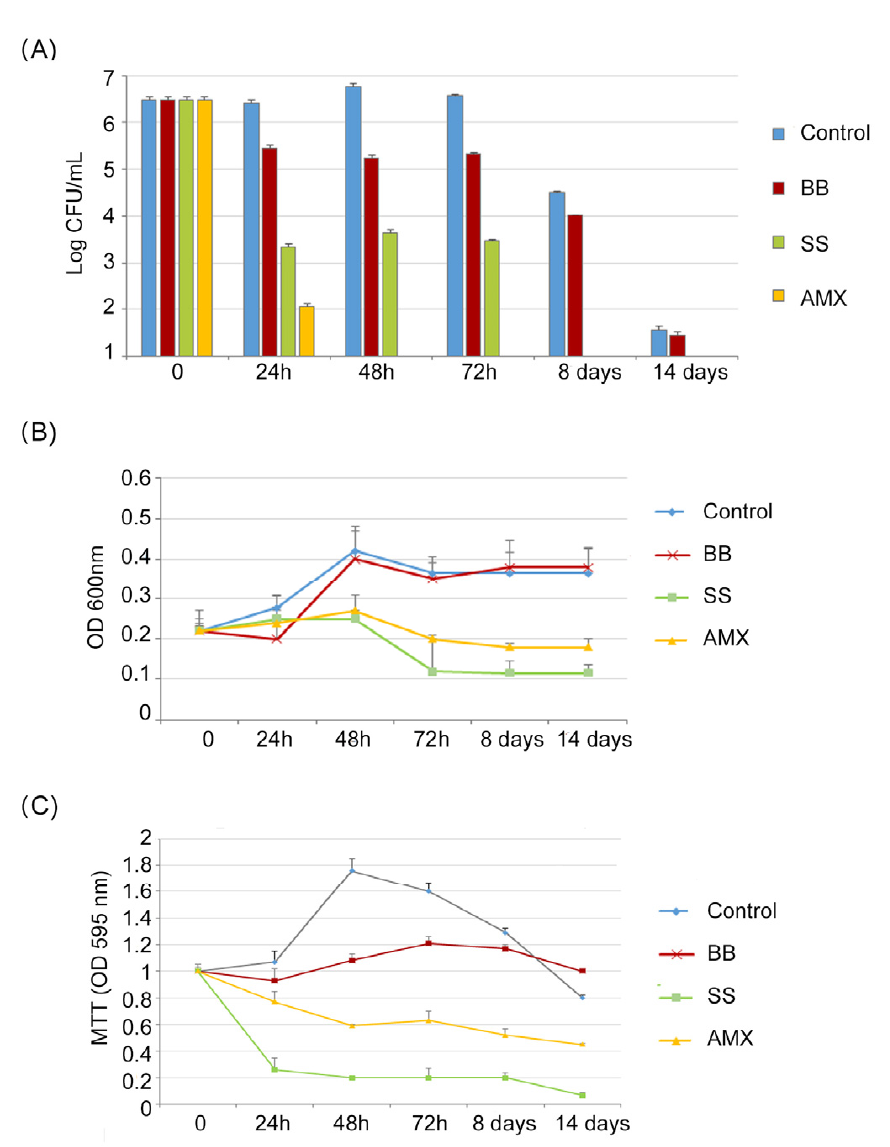
Figure 2. Induction of dormancy . ( A ) Culturable cell numbers of H. pylori incubated in a microaero- bic atmosphere at 37 ◦ C under different conditions. Control (BB + 2% FCS); BB (Brucella broth) and SS (saline solution) for the VBNC protocol; AMX (amoxicilllin 10xMIC) for the AP protocol recorded at t = 0, 24 h, 48 h, 72 h, 8 days, and 14 days. ( B ) Total number (OD 600 ) of H. pylori incubated in a microaerobic atmosphere at 37 ◦ C under different conditions, in time. ( C ) MTT assay of H. pylori for the evaluation of metabolic activity during incubation in a microaerobic atmosphere at 37 ◦ C under the different conditions over